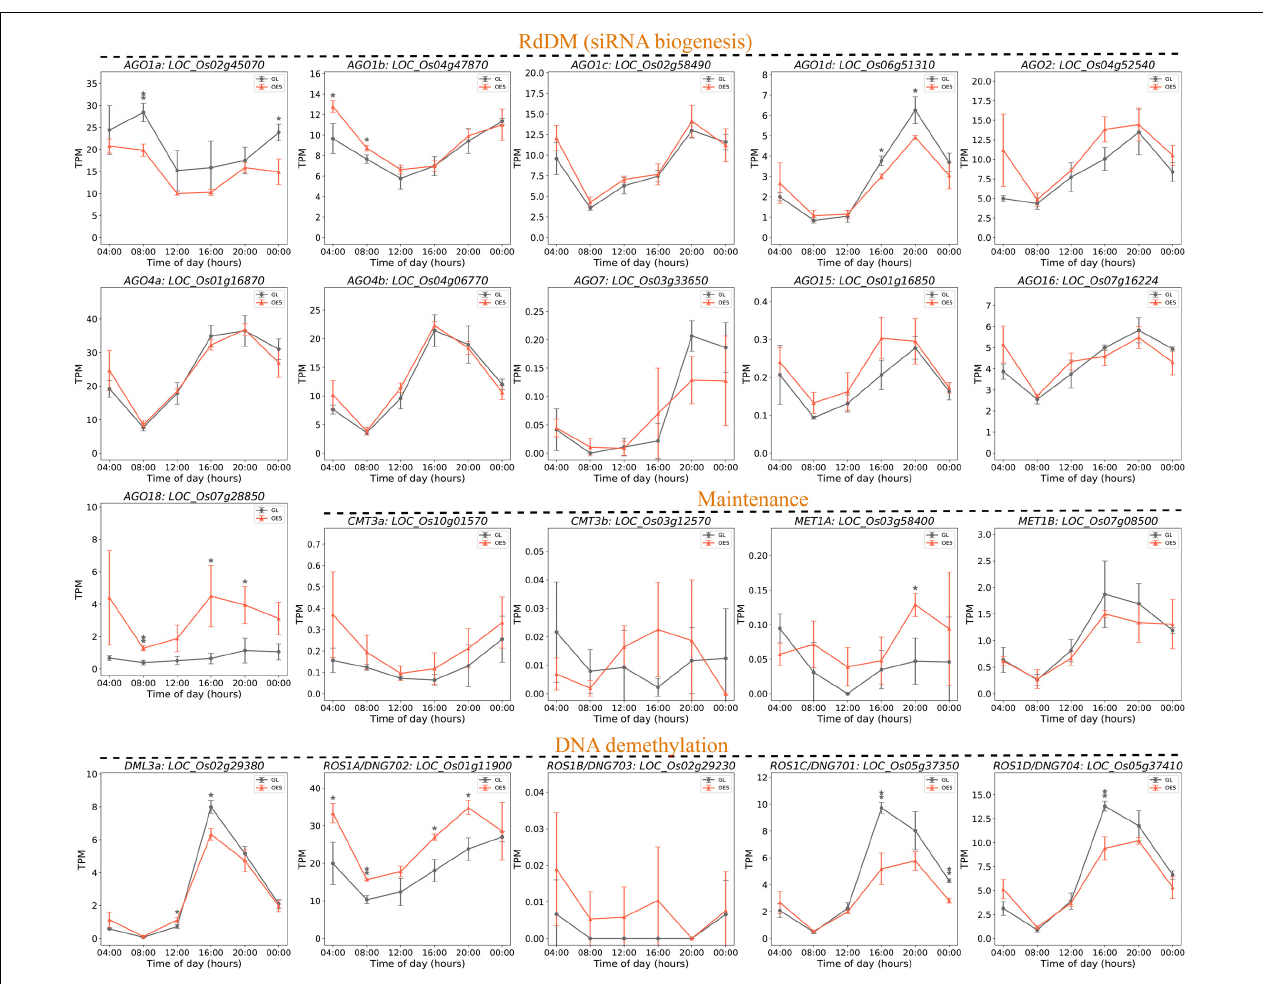
FIGURE 7 | Diurnal expression patterns of DNA methylation-related genes. Eleven AGO family members in the RdDM pathway, four genes for methylation maintenance, and five for DNA demethylation were presented with data of time-course transcriptomes. The three groups of genes are arranged under horizontal dash lines with group names of RdDM (siRNA biogenesis), Maintenance, and DNA demethylation. The other five DNA methylation genes and 11 siRNA biogenesis genes in the RdDM pathway are shown in Supplementary Figure 5 . The asterisks above curves mean significance difference at P < 0.05 (one asterisk) and P < 0.01 (two